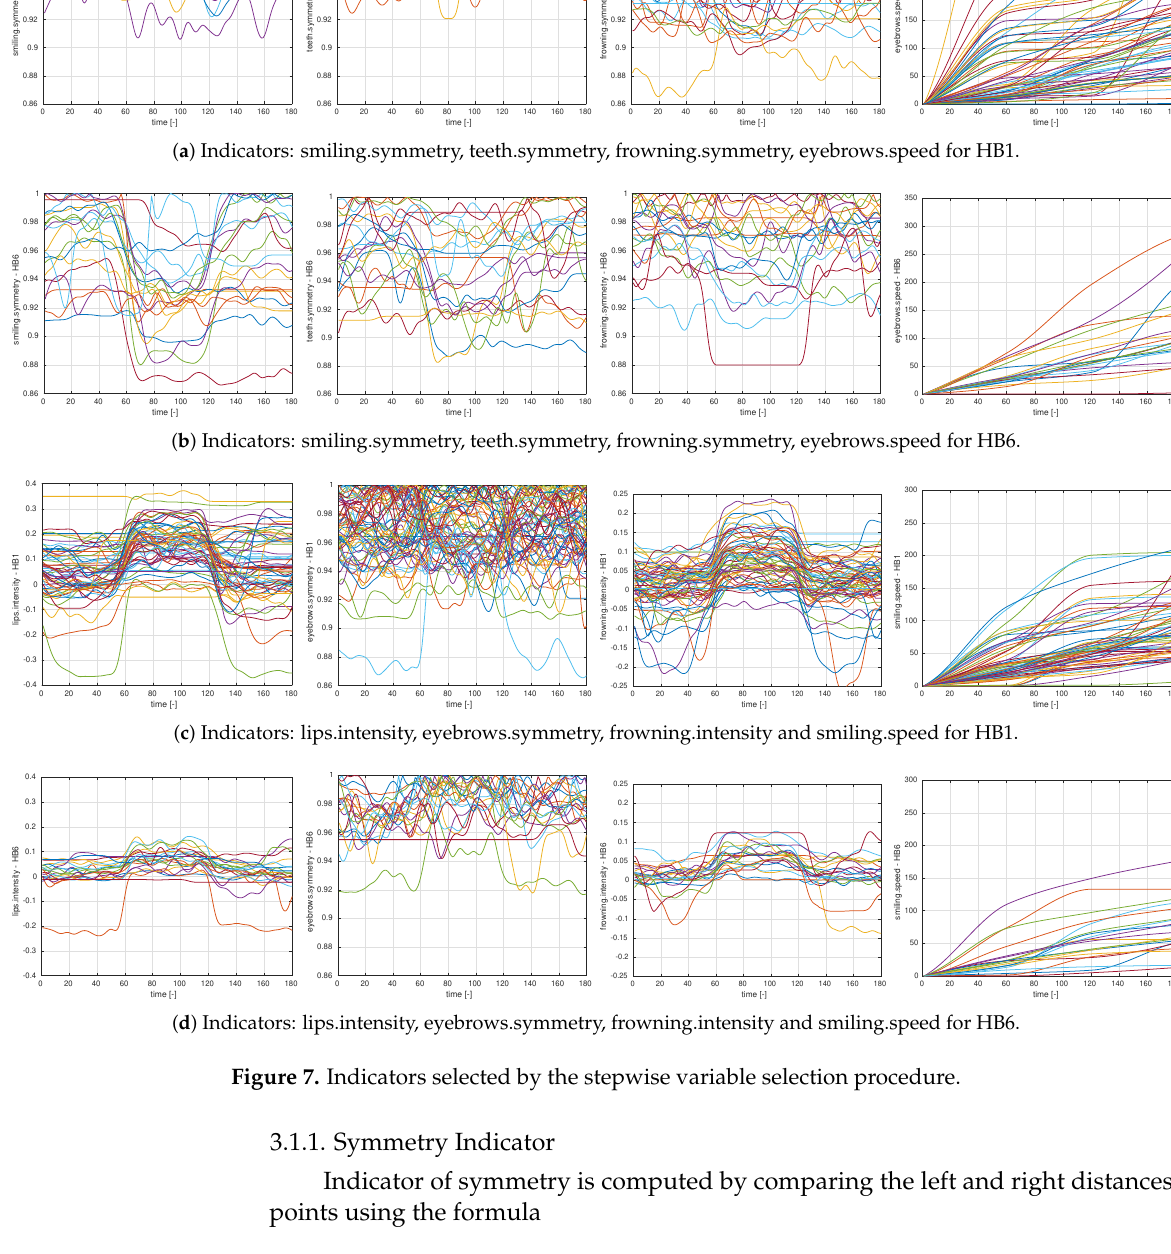
where R 1 and R 2 denotes two points on the right and L 1 and L 2 on the left side of the face. For Raising and Frowning we use the distance between the inner eyebrows (points 4 and 10) and inner corners of the eye (points 2 and 8). For Smiling and Baring we use the distance between the outer corners of the mouth (points 14 and 15) and that between the outer corners of the eye (points 3 and 9). Eye corners were chosen as reference points since they were found to be the most stable during the